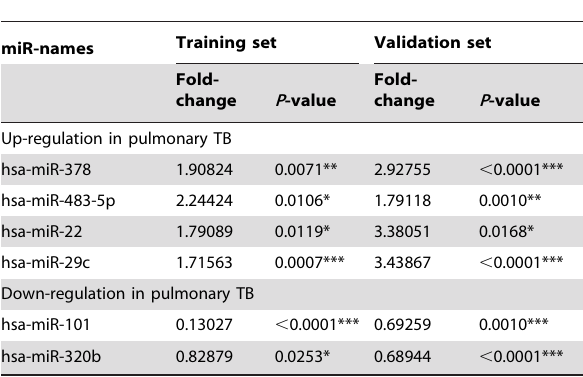
Table 4. Differentially expressed serum miRNAs in pulmonary TB compared to the healthy controls in both the training set and the validation